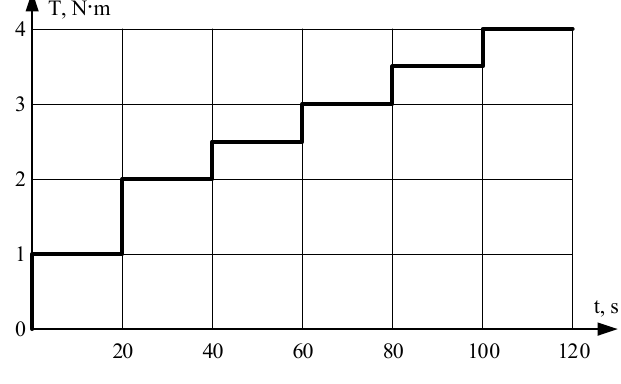
Figure 9. Commanded load torque.